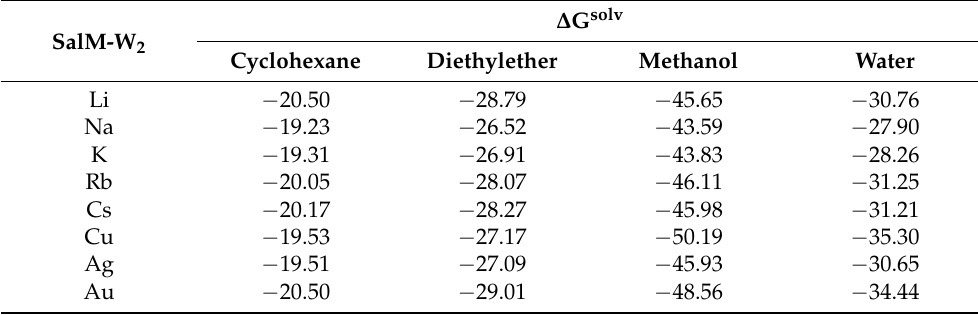
∆ G solv = E solvent − E gas-phase